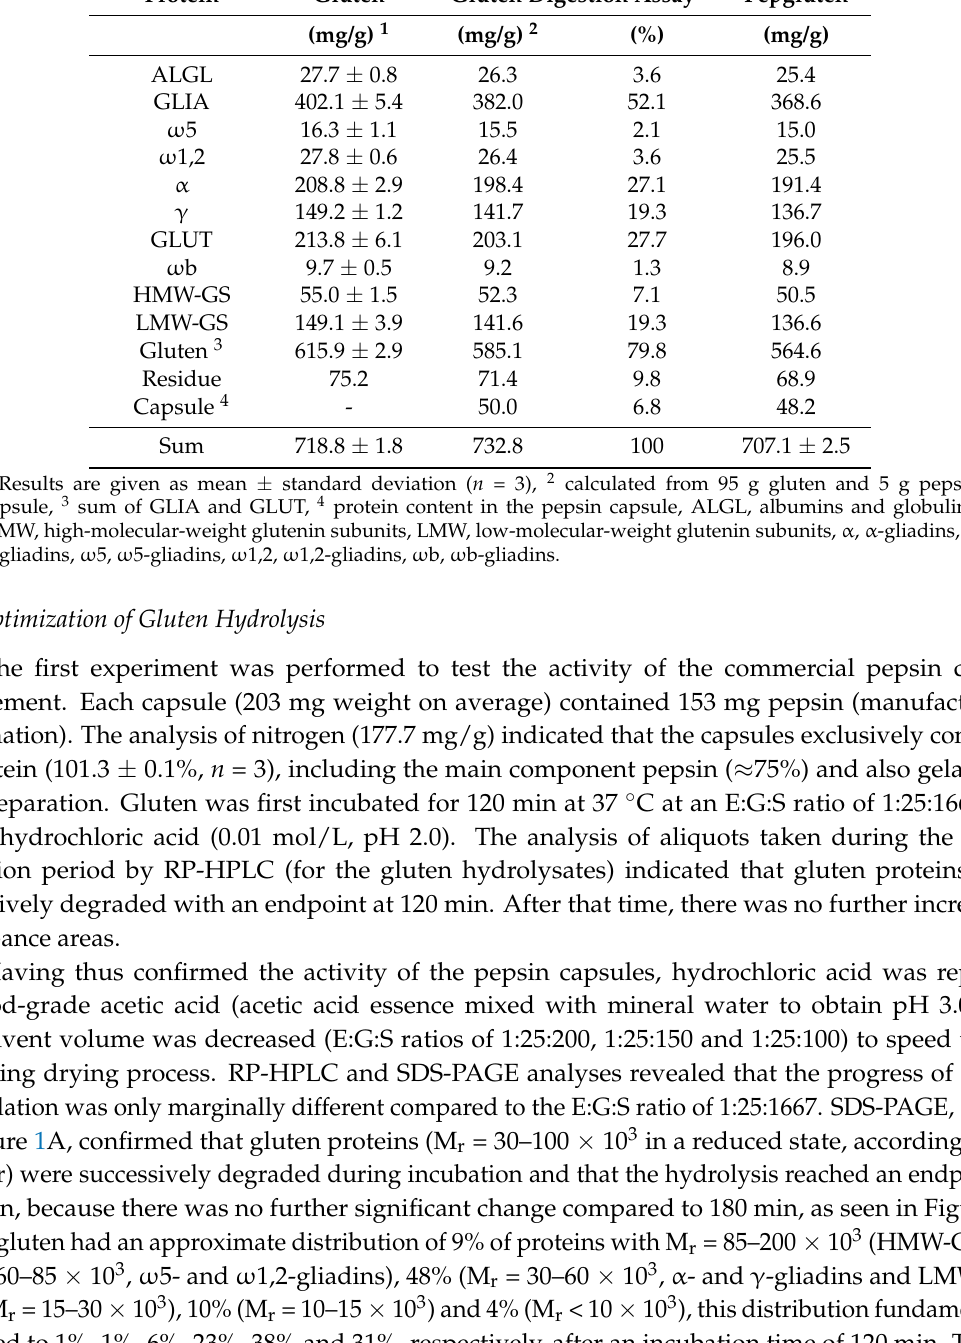
Table 2. Composition of the protein fraction in gluten and pepgluten. Protein Gluten Gluten Digestion